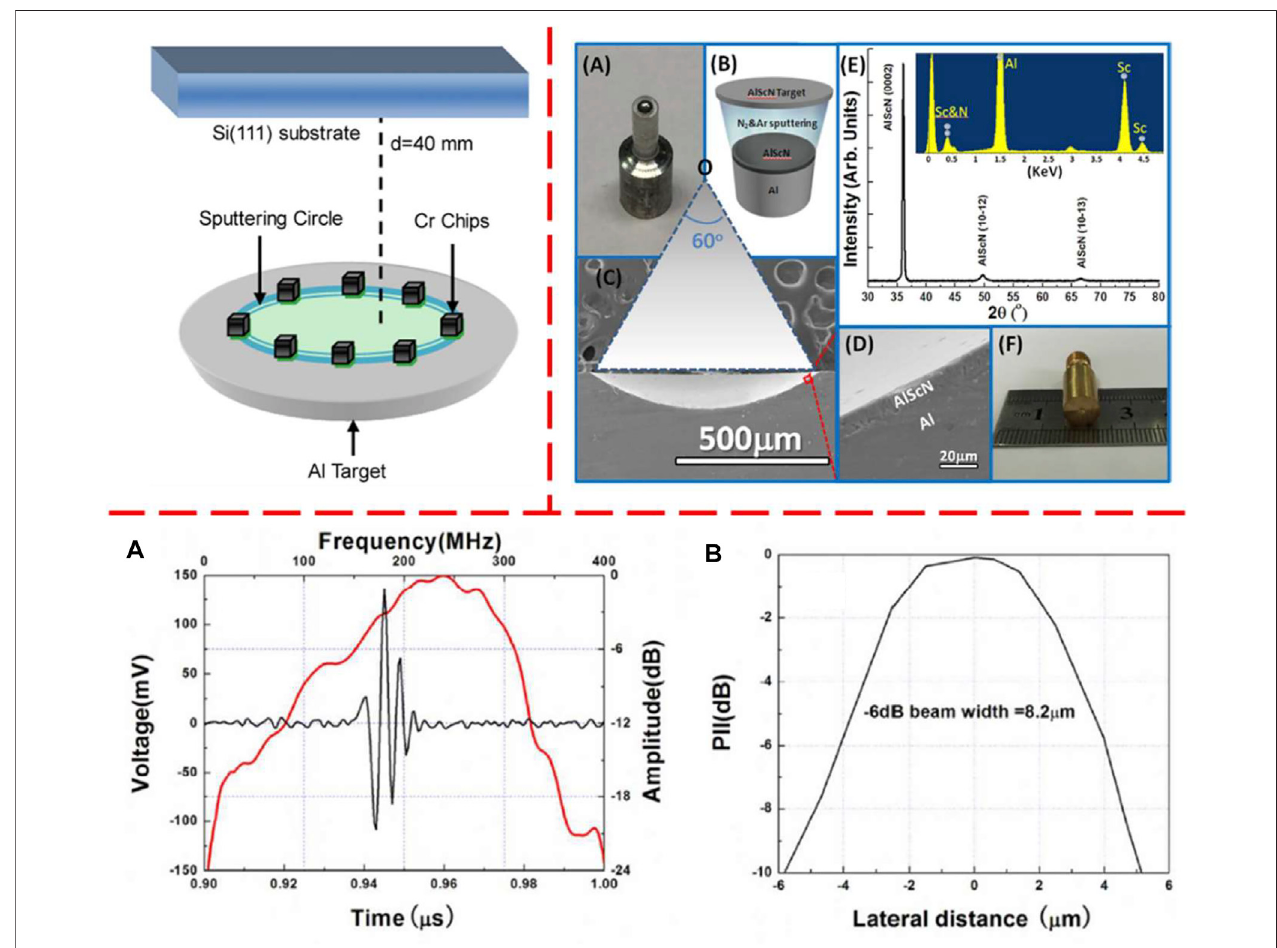
FIGURE 3 | Schematic drawing of the Cr doping sputtering system (top left) ; preparation of Cr-doped AlN UHF Ultrasonic Transducer (top right) ; Time-domain pulse/echo response (black line) and frequency spectrum (red line) and resolution of Cr-doped AlN UHF Ultrasonic Transducer (bottom) .